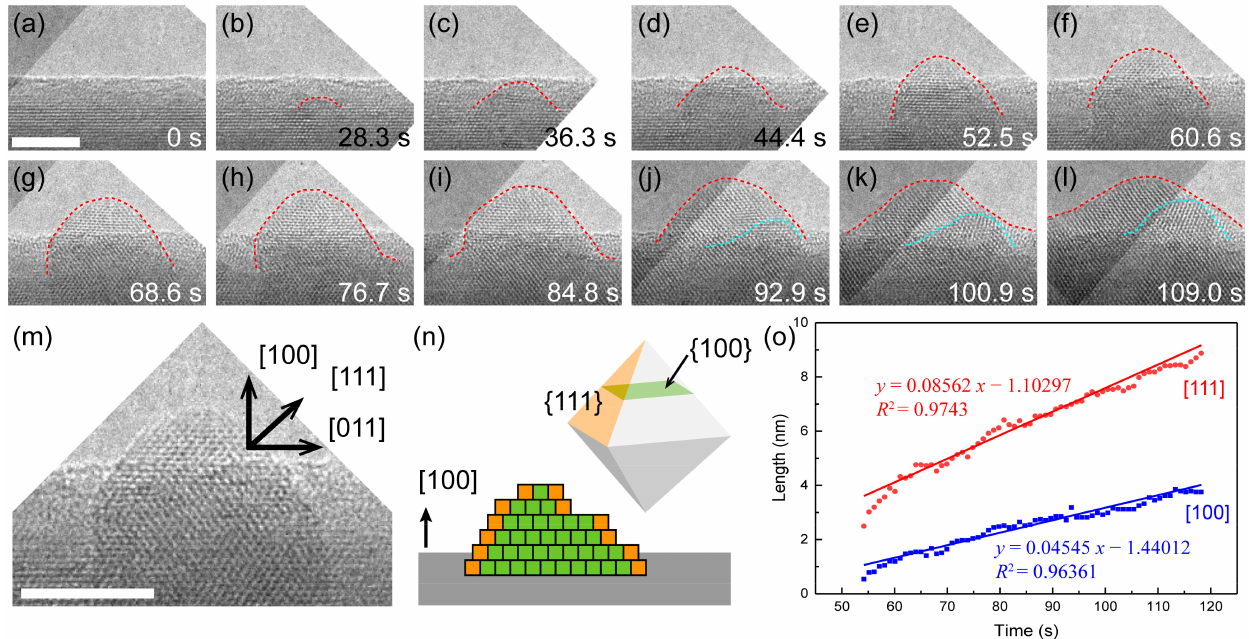
Figure 5. Growth kinetics of the low-index surface of Ag 2 O. ( a – l ) Time-resolved HRTEM images of atomic growth process of Ag 2 O nanocrystal. ( m ) HRTEM image showing the “hill-like” growth of Ag 2 O nanocrystal. ( n ) Scheme of the hill-like growth front. ( o ) Growth rate measured by the increment of oxide size vs. time. Dose rate at 10,600 e · Å − 2 · s − 1 . Scale bar at 2